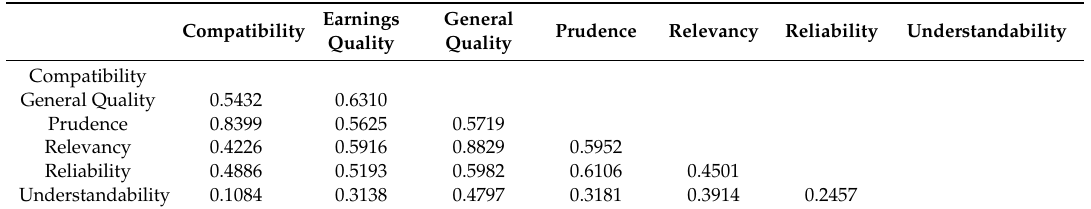
Table 5. Heterotrait-Monotrait Ratio (HTMT).